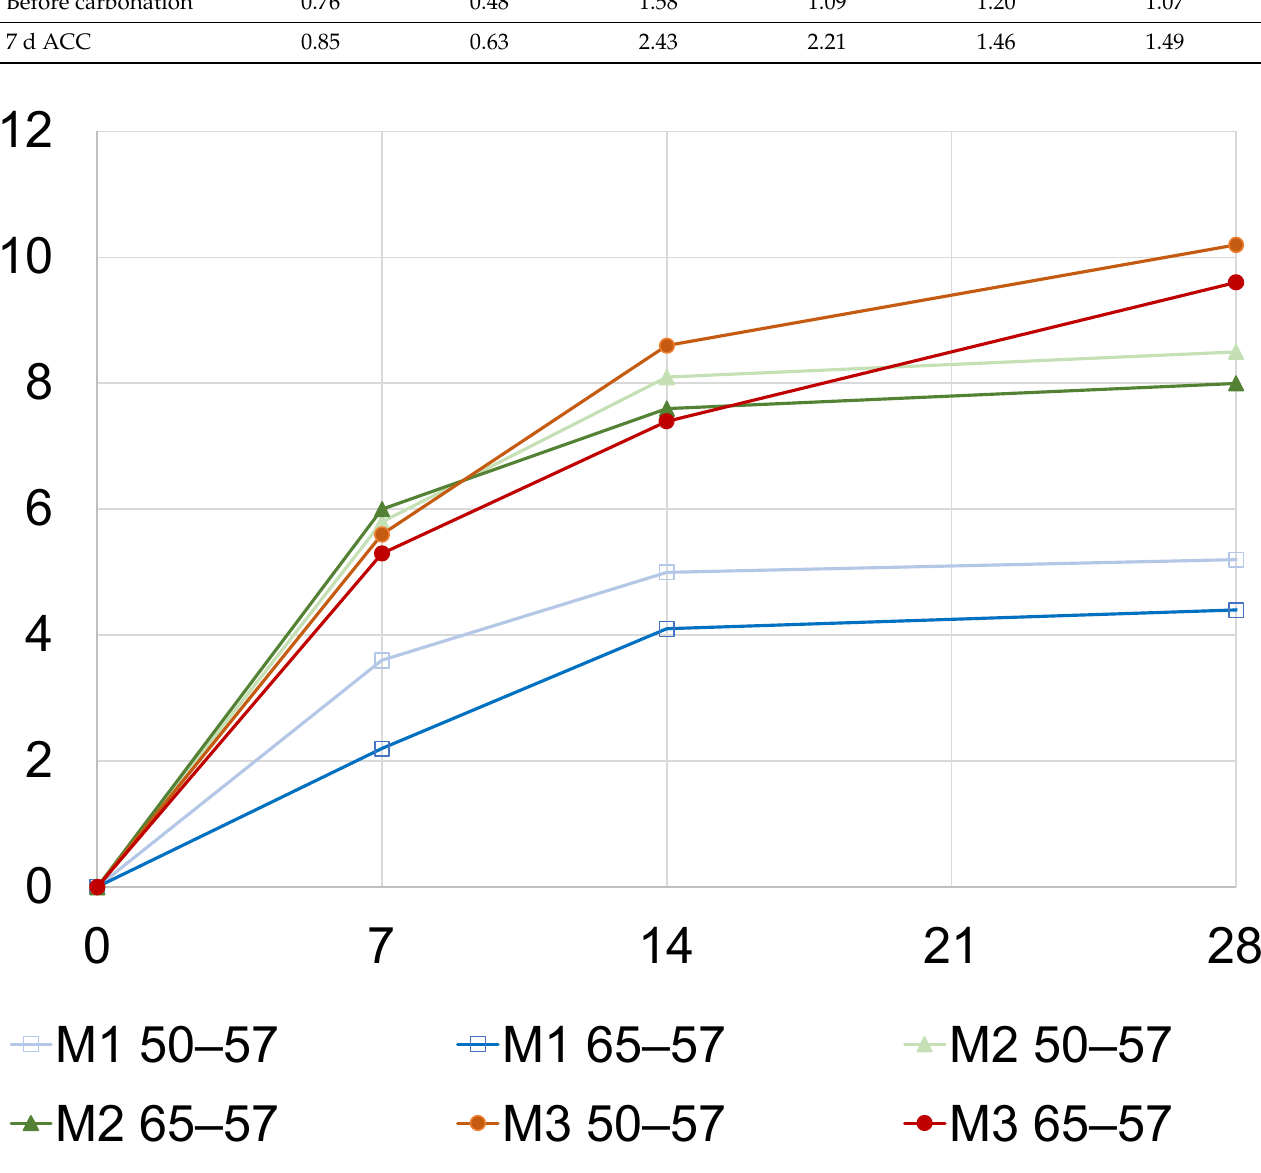
, 20 °C and ambient pres- 2